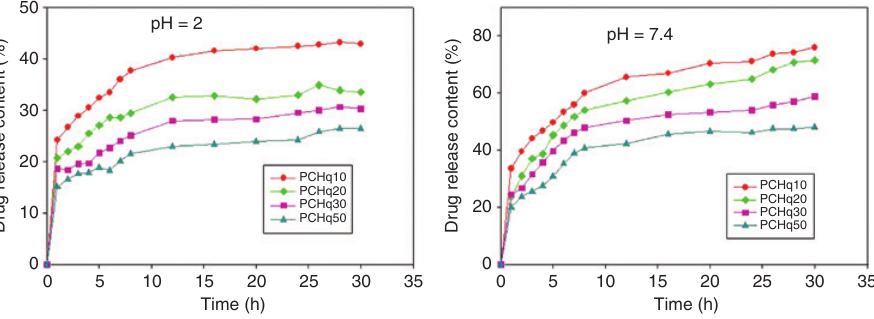
Figure 6: In vitro Hq released content from PCHq nanoparticles according to testing